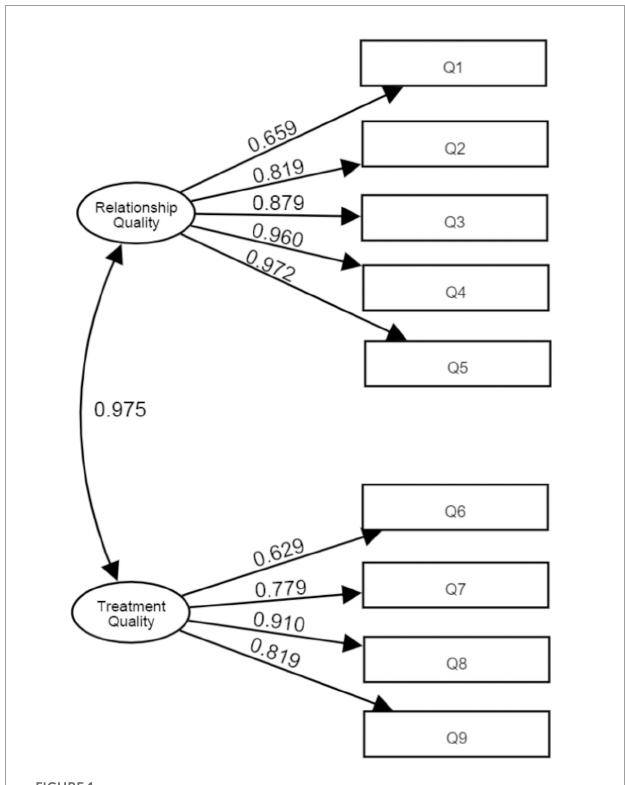
FIGURE1 Factor structure of patient-doctor relationship questionnaire 9-item Chinese